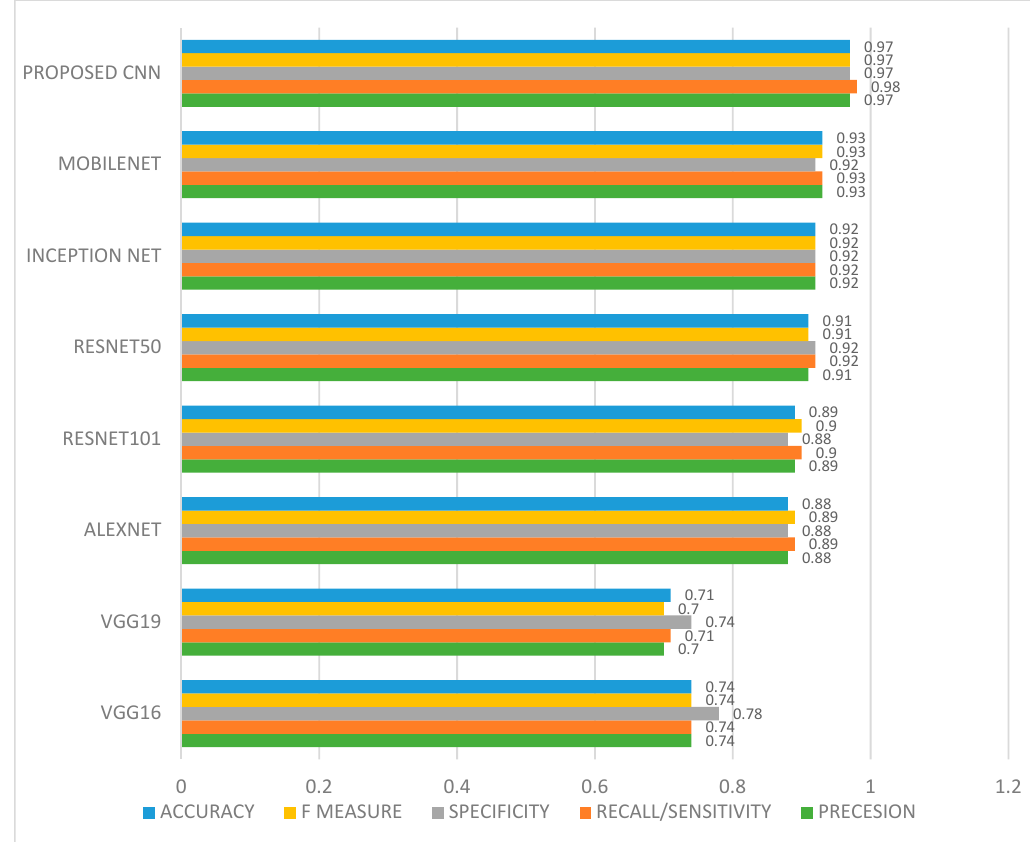
Figure 5. Performance evaluation using accuracy, F-measure, specificity, recall and precision.